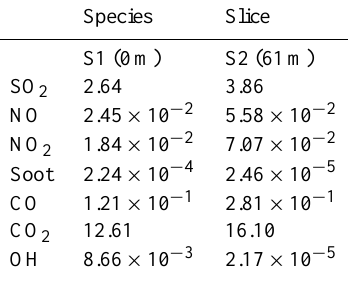
Table 1. Mass flow rates obtained with the combustion model. The capital S and the number at the right represent the number of the slice. The number in parenthesis shows the height of the slice with respect to the tip of the simulated flame. All the estimates are in kgs − 1